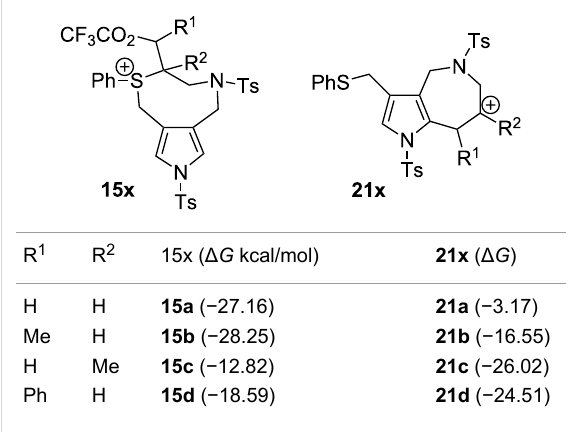
Table 2: DFT Calculation of the two pathways: from 14 to 15x or from 14 to 21x